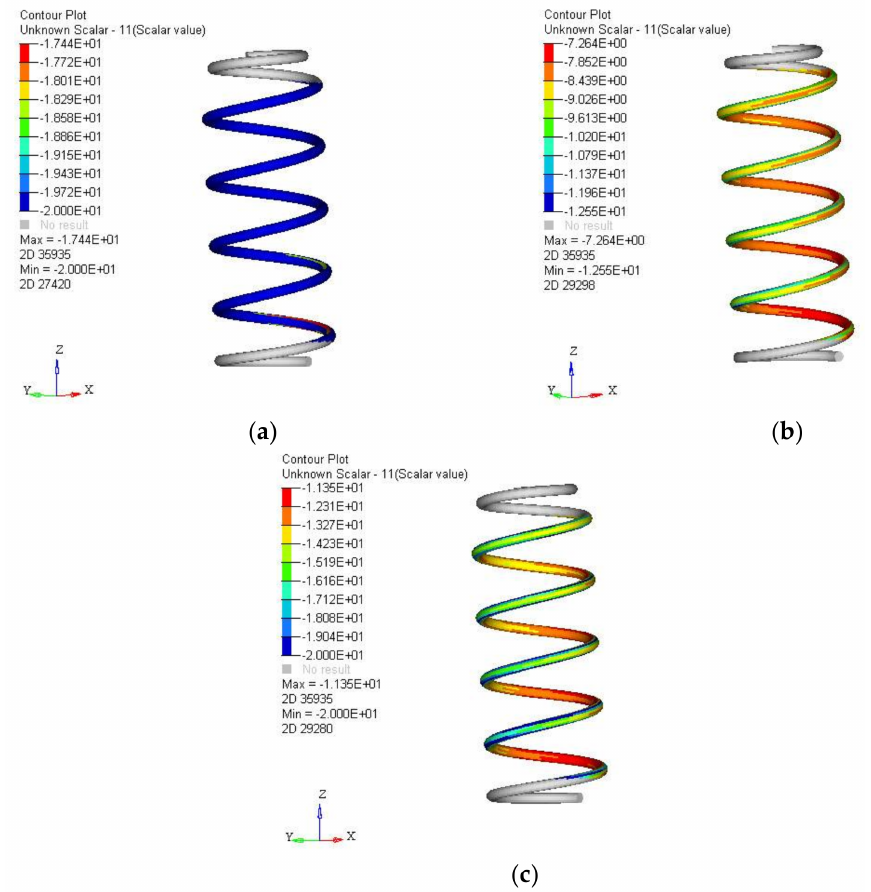
Figure 12. Fatigue damage contour plot of spring using Lalanne PSD cycle count and absolute maximum principal stress under different roads: ( a ) highway; ( b ) residential; and, ( c ) rural.